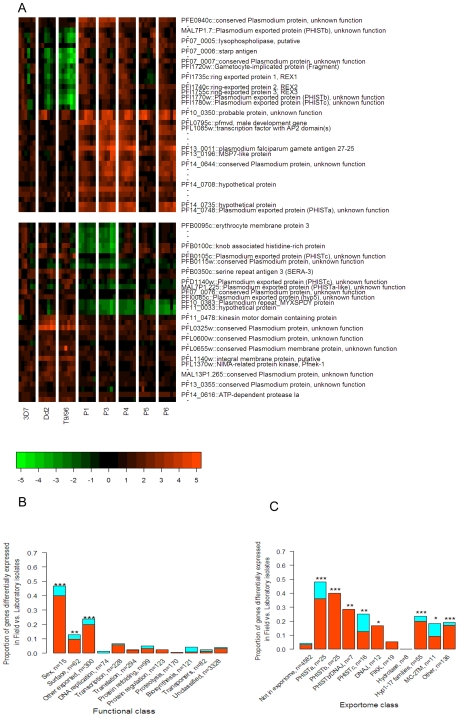
Genes that Differed Most Between Field and Laboratory Isolates and Their Functional Classification.
A. Individual time point expression profiles for the 20 up-regulated (top panel) and 20 down-regulated genes (bottom panel) with lowest P-values in field vs. laboratory isolates comparisons. Rows are sorted by chromosomal location. All probes per gene, whether significant or not, are shown to illustrate the good correspondence across probes within gene. The data shown are actual expression values relative to the 3D7 reference material on the log2 scale (see color bar), i.e., they have not been row-mean normalized. B. Genes were classified according to function based on their PlasmoDB annotations and GO terms, and bioinformatics studies (Table S1). The proportion of each class that was differentially expressed (>1.5-fold difference and P<0.01) between field and laboratory isolates was significantly higher in genes coding for sexual stage parasites, surface proteins and genes containing an export motif (exportome) than for other genes. Differentially regulated genes tended to be more often up-regulated (red) than down-regulated (light blue). C. Genes were classified according to their class within the exportome [57]. With the exceptions of the Maurer's Cleft genes (MC-2TM) and the FIKK kinases, all of the sub-classes had significantly higher numbers of up-regulated in field vs. laboratory isolates than non-exportome genes (left bar). Numbers per class are shown in the axis labels. Significance levels for differences in proportions of each class vs. all other classes using the hypergeometric test are indicated by *, P<0.05; **, P<0.01; ***, P<0.001.